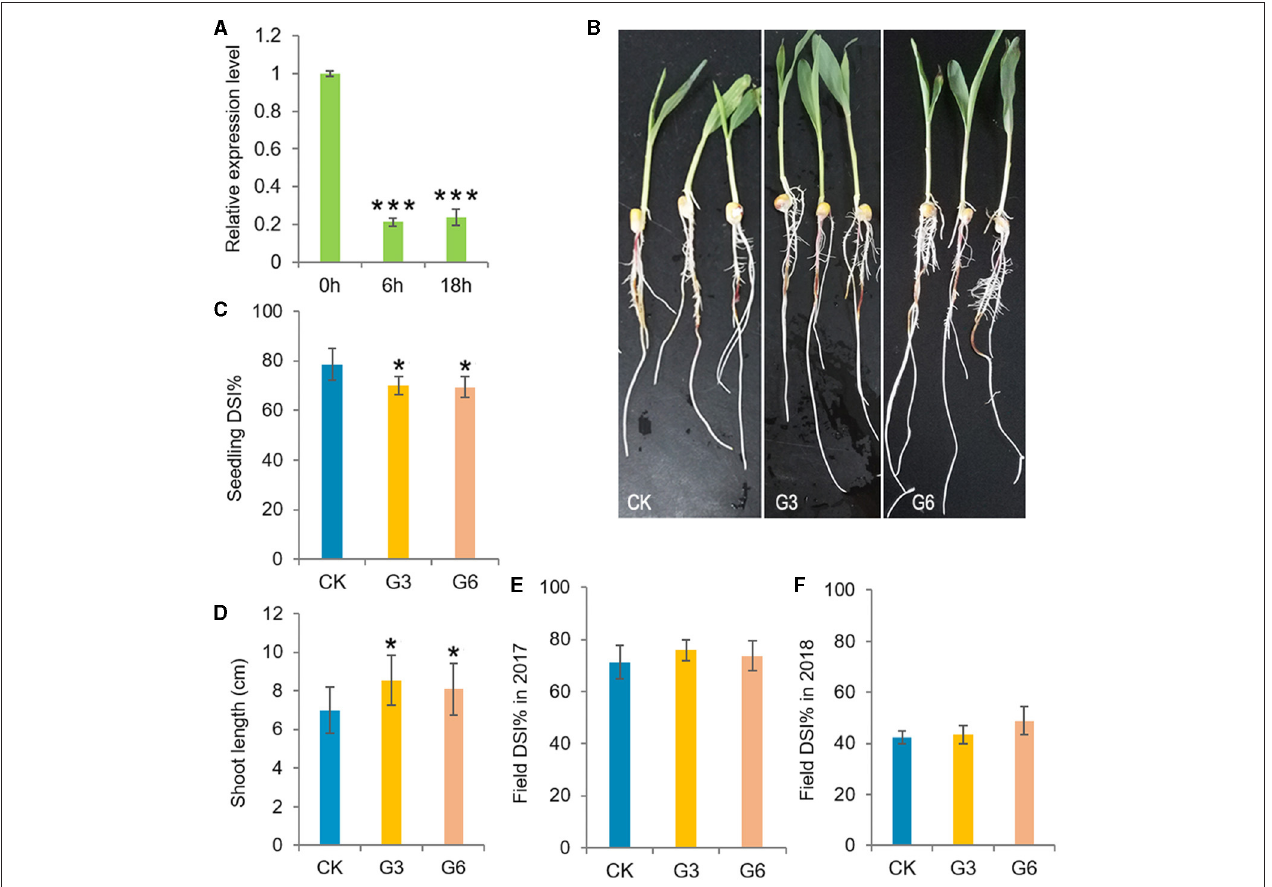
FIGURE 3 | Analysis of the disease resistance of transgenic maize with a significant reduction in ZmGT-3b expression. (A) ZmGT-3b expression in young CK (maize inbred line LH244, wild type) seedlings significantly decreased after F. graminearum inoculation. “0,” “6,” and “18 h” indicate hours after the inoculation of seedlings at 5 DAG. Both shoot and root growth (B) were much better in the inoculated GT-KD seedlings compared with the inoculated CK seedlings with similar levels of disease severity, the disease severity index (DSI, n > 20 individual seedlings) values of G3 and G6 seedlings were also significantly lower than that of CK seedlings (C) , and the shoot length of the diseased seedlings of G3 and G6 were longer than that of CK [ (D) , n > 20 individual seedlings]. (E,F) The DSI of mature transgenic maize ( Zea mays ) plants was similar to (or higher than) that of CK plants in field inoculation experiments. The data of DSI are mean ± SD ( n > 25 individual plants). The asterisk indicates a statistically significant difference between CK and the GT-KD lines, as calculated by a paired Student’s t -test (* p < 0.05, *** p < 0.001).